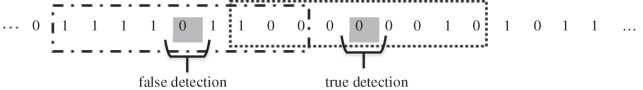
Depiction of the NeighFilt operation on the mask file where ‘0’ represents the detection of noisy coefficient via the GOF test while ‘1’ denotes the detection of signal. False detection is found if the noisy coefficient is surrounded by the signal coefficients and vice versa.